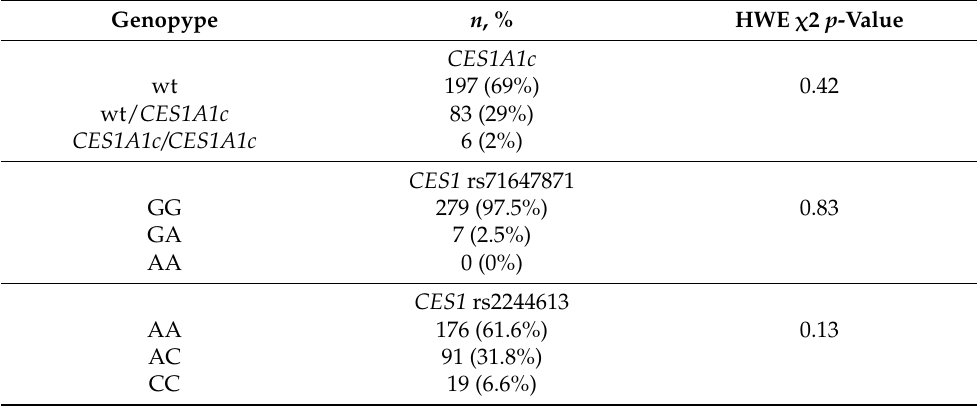
Table 2. CES1 variants frequencies in studied